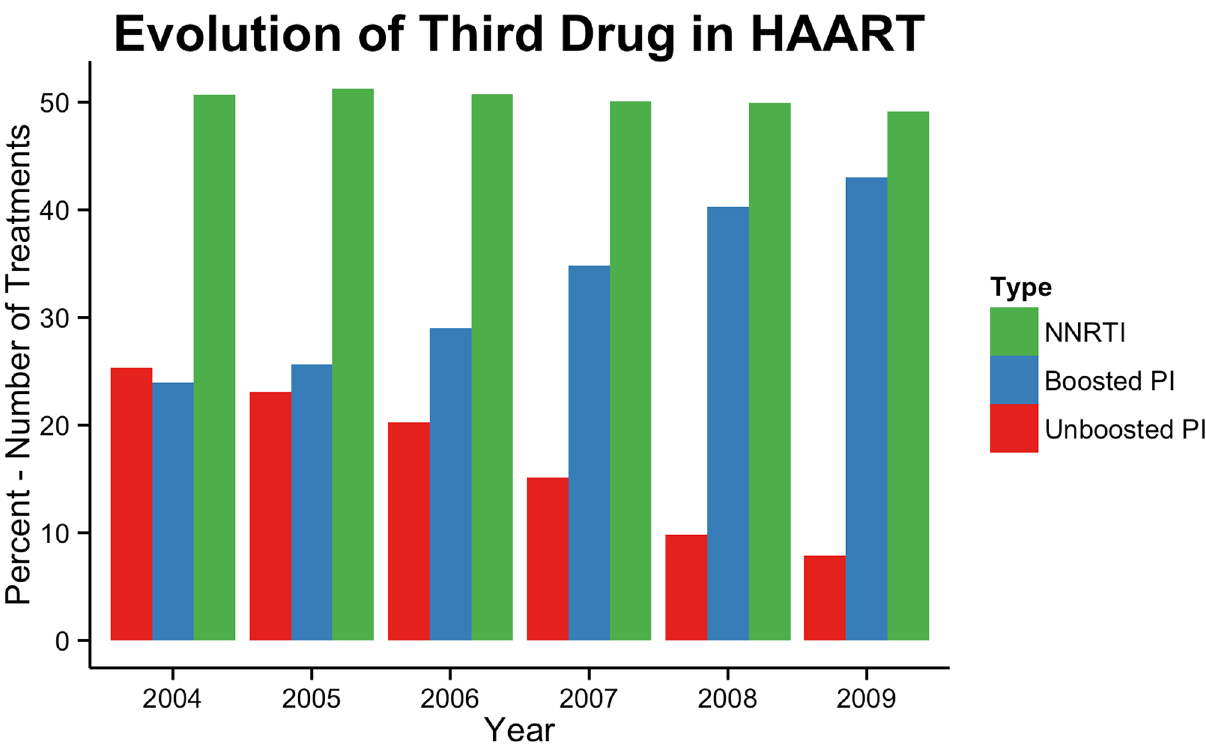
Fig 7. Evolution of third ART treatment over time. Number of treatments containing non-nucleoside reverse transcriptase inhibitors (NNRTIs), unboosted protease inhibitors (PIs) and ritonavir-boosted PI from 2004 to